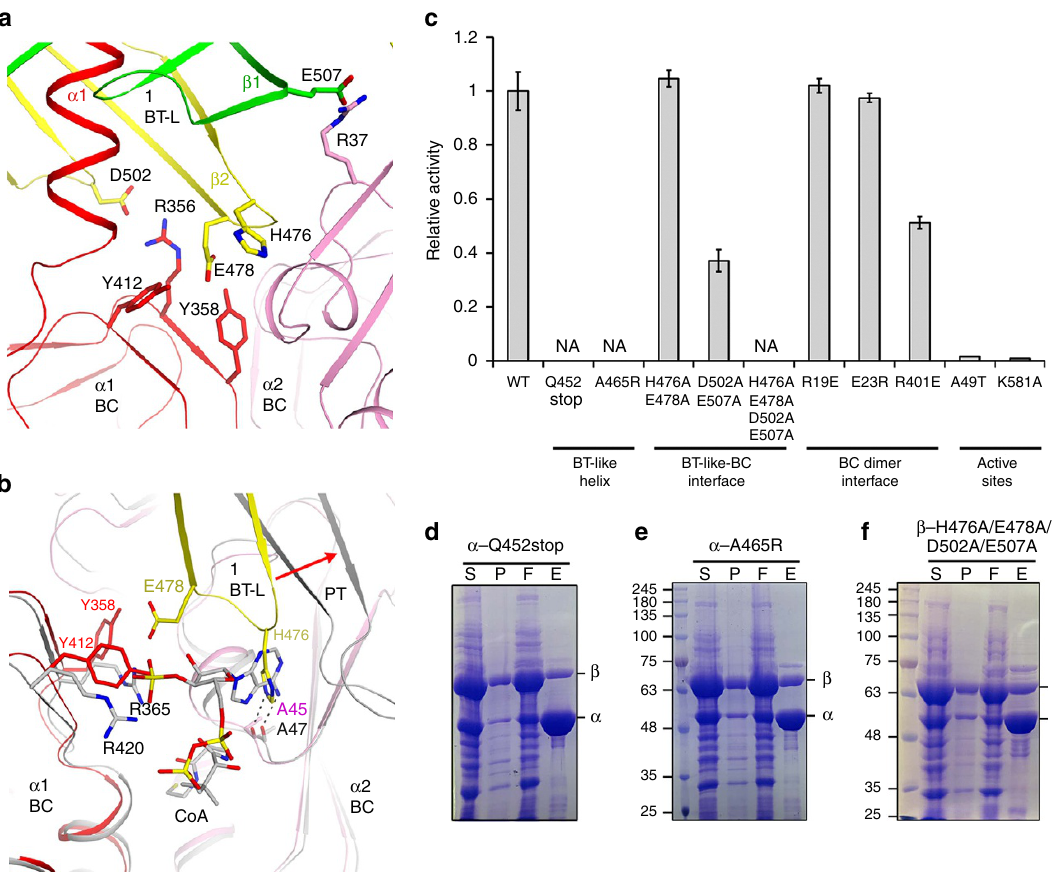
Figure 4 | Mutagenesis studies to assess the structural observations. ( a ) Interactions between the BT-like domain and the BC dimer at the holoenzyme interface. ( b ) Overlay of the structure of MfPC (in colour) and SaPC (in grey) in complex with CoA (grey for carbon atoms) 10 . The red arrow indicates the difference in position of the BT-like domain in MfPC and the PT domain in SaPC. ( c ) Catalytic activities of wild-type and mutant MfPCs. The pyruvate concentration is at 20mM. The error bars represent the s.d. from three independent measurements. NA, no activity observed under the condition tested. ( d ) Deletion of the a helix of the BT-like domain, or mutation of one of its Ala residues (A465R), abolished the formation of the MfPC holoenzyme. The two subunits were co-expressed in E. coli , with the a subunit carrying a His-tag. E, eluate from the Nickel column; F, flow-through of the Nickel column; P, pellet; S, soluble fraction. ( e ) Mutation of an Ala residue (A465R) in the helix of the BT-like domain abolished the formation of the MfPC holoenzyme. ( f ) A quadruple mutation in the interface between the BT-like domain and BC blocked holoenzyme